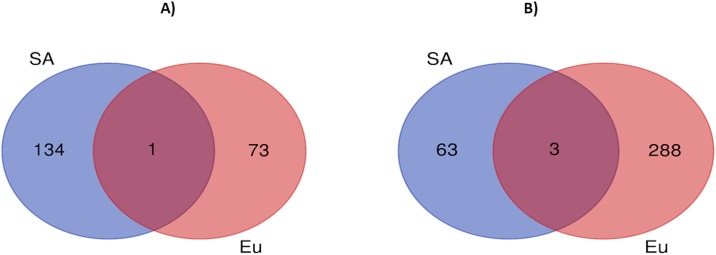
Venn diagrams to identify overlap between DMRs (mapped to genes) of DBP (A) and SBP (B) analyses conducted for South Asian and European groups.SA denotes South Asian and Eu denotes European ancestry.